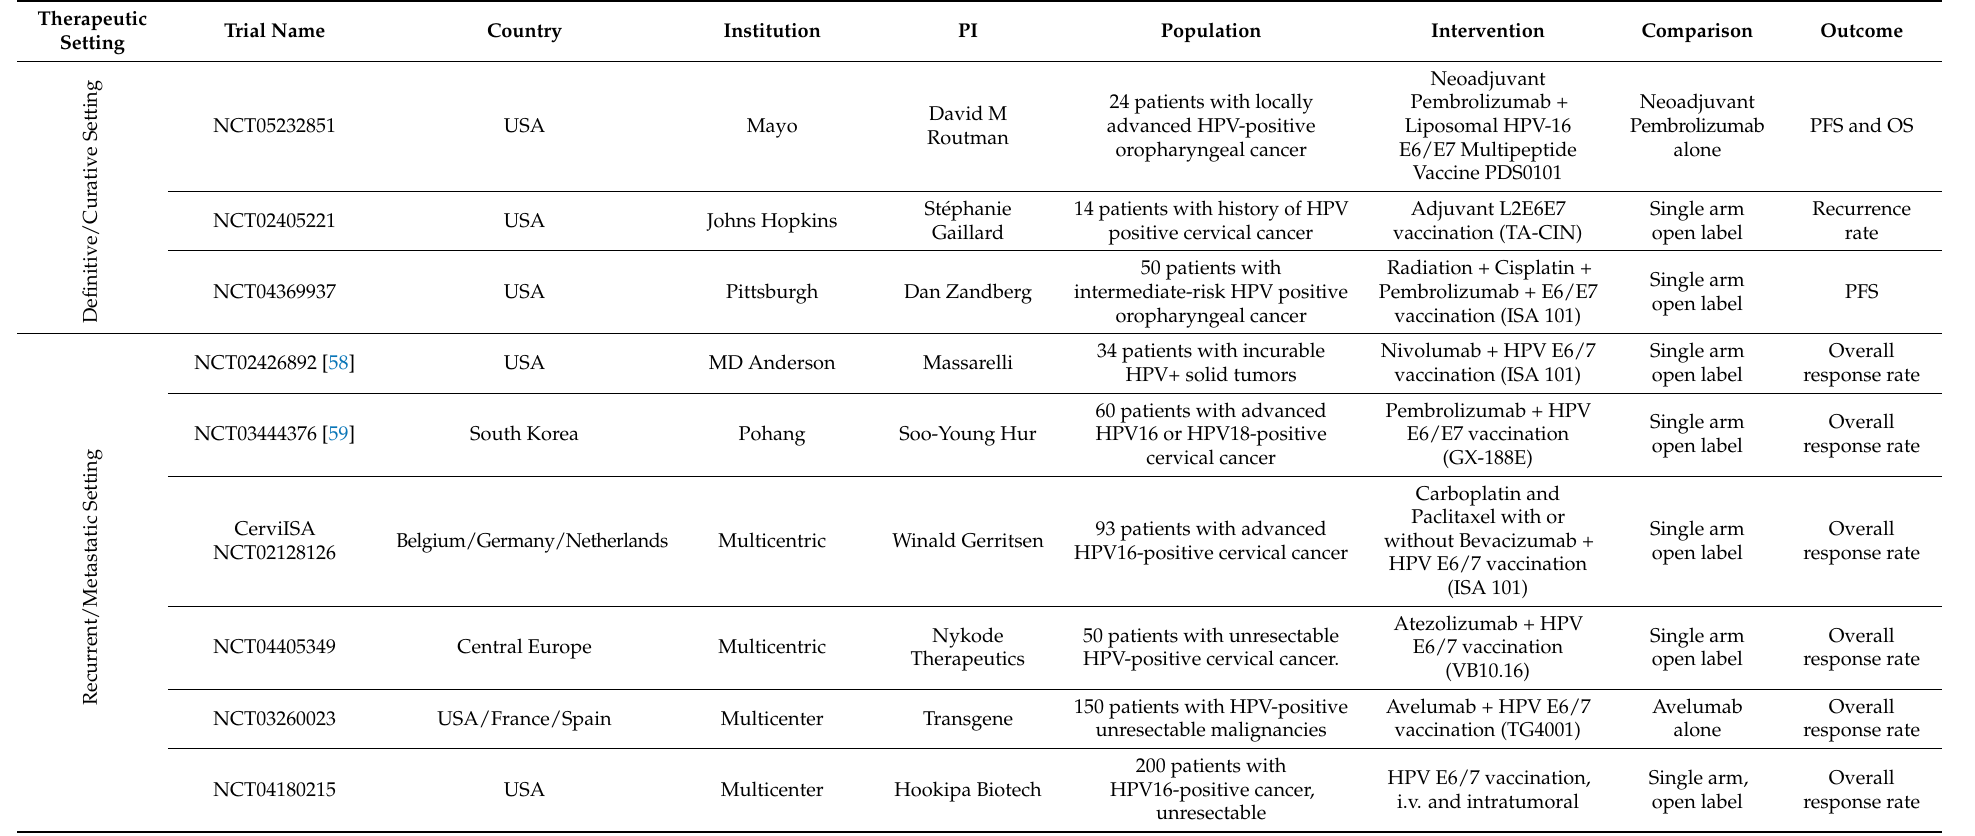
Table 3. Overview of therapeutic vaccines for HPV-positive oropharyngeal and cervical